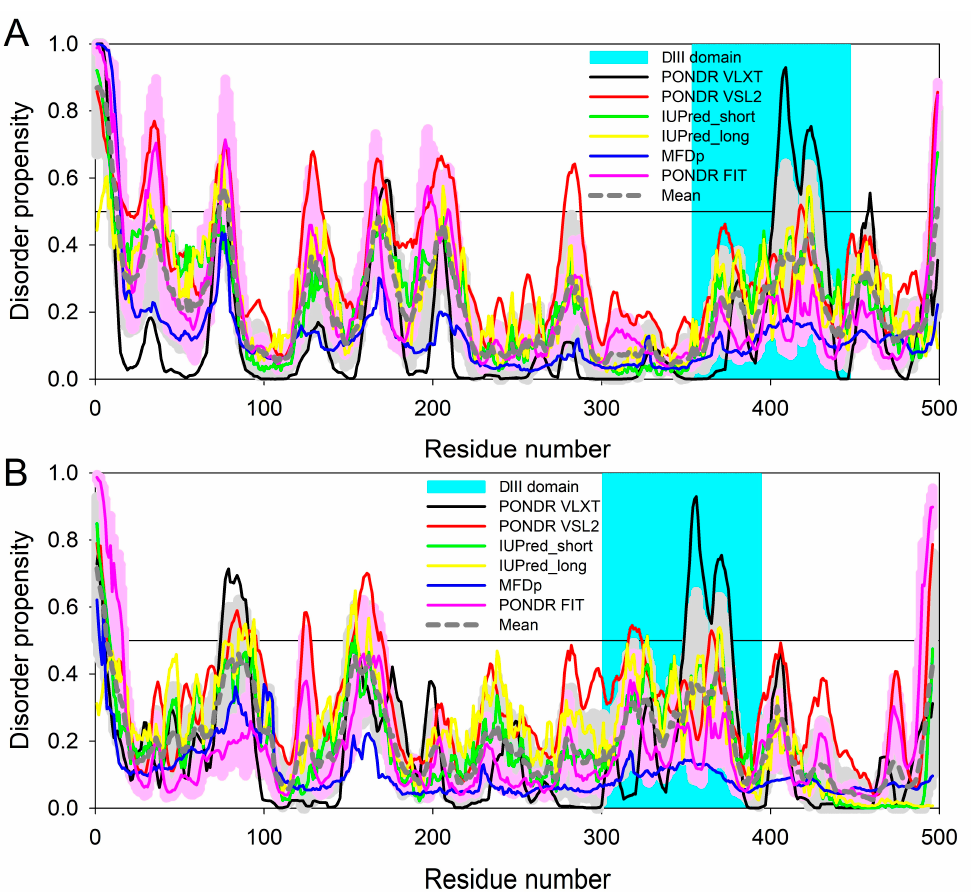
Figure 5. Intrinsic disorder predisposition of the chimeric OmpF-EIII protein ( A ) and the mature tick-borne encephalitis virus E protein ( B ) evaluated by several common per-residue predictors of intrinsic disorder, such as PONDR ® VLXT (black line), PONDR ® VSL2 (red line), IUPred_short (green line), IUPred_long (yellow line), MFDp (blue line), and PONDR ® FIT (pink line). These computational tools were selected because of their different sensitivity to different disorder-related features. The bold, dashed dark gray line shows the mean disorder propensity calculated by averaging the disorder profiles of individual predictors. The light pink shadow around the PONDR ® FIT curve shows the error distribution for this predictor, whereas the light gray shadow around the mean disorder propensity curve represents the distribution of standard deviations for this tool. The position of the DIII domain of the tick-borne encephalitis virus E protein (residues 354–447 of the chimeric protein) is shown by the light cyan bar. The most C-terminal part (residues 448–499 of the chimeric protein) corresponds to a stem of the E protein. In these analyses, the predicted intrinsic disorder scores above 0.5 are considered to correspond to the disordered residues or regions, whereas residues and regions with the disorder scores >0.2 are considered as flexible.